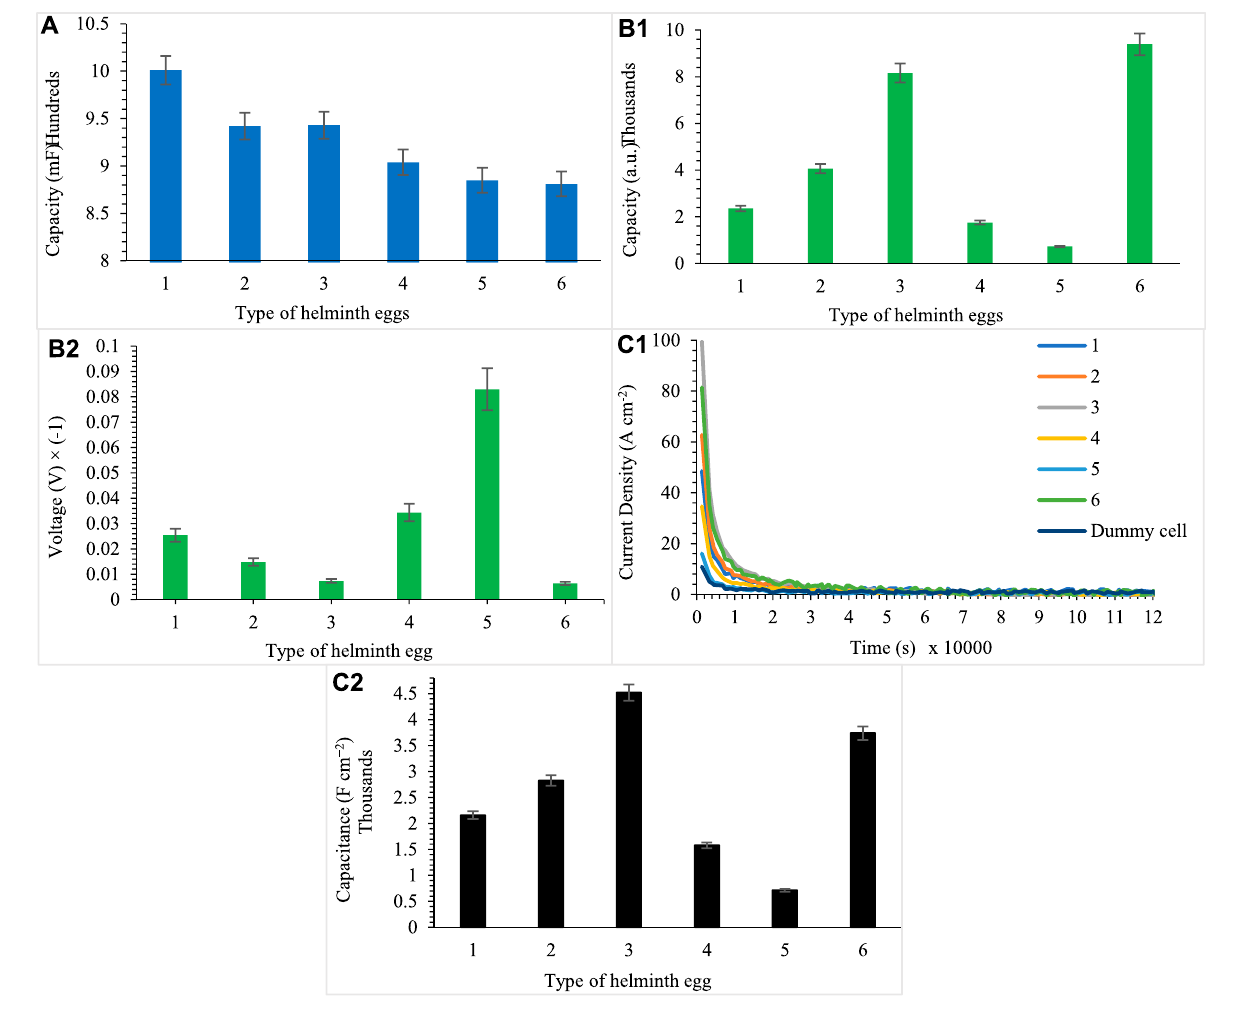
This experiment resulted in an equivalent circuit with four independent key elements: capacitor, inductor, resistor, and negative resistor as mentioned . The existence of these